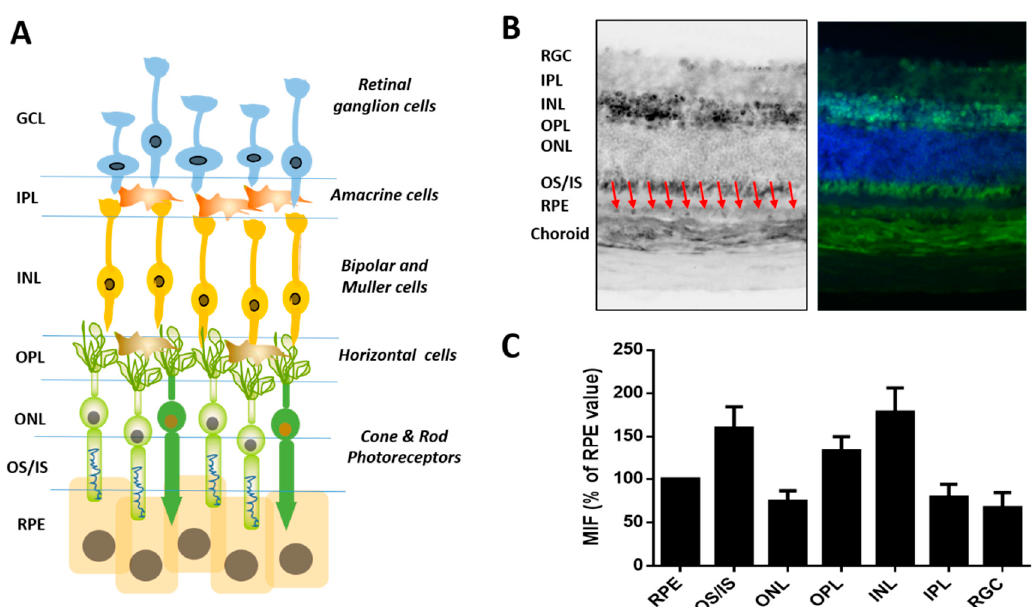
Figure 4. Immunohistochemistry of GLO1 in mouse retinal tissues. ( A ) Cross-sectional, cellular schematic of the retina illustrating its three primary layers comprised of the ganglion cell layer (GCL), containing retinal ganglion cells (RGC), inner nuclear layer (INL), hosting interneurons of amacrine, bipolar and horizontal cells as well as Müller glial cells, and outer nuclear layer (ONL), housing rod and cone photoreceptors. The sensory tissue, or neuroretina, is connected to the retinal- pigmented epithelium (RPE). Red arrows indicated the RPE layer. ( B ) Representative picture of GLO1 immunostaining in retinal samples from WT mice. ( C ) Mean intensity fluorescence of GLO1 normalized to the value in the RPE. Data shown are mean ± standard errors of the means (SEM).